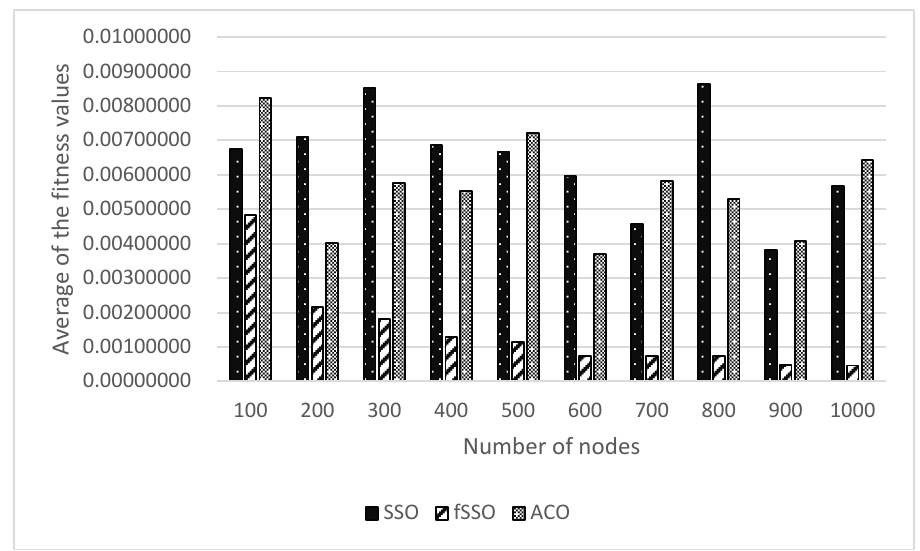
Figure 8. Maximum of the fitness values for ten benchmarks. Energies 2018 , 11 , x FOR PEER REVIEW